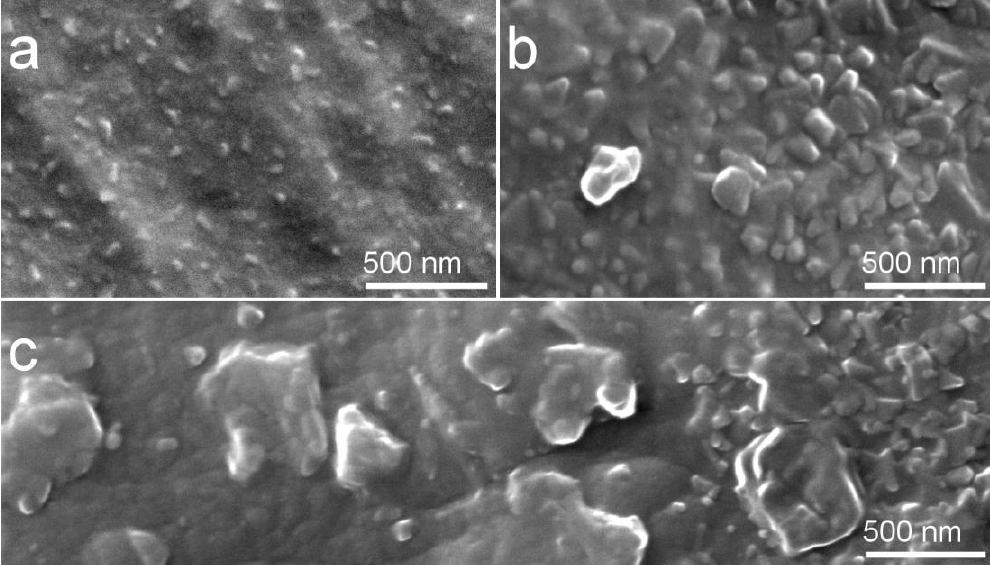
Figure 4. Scanning electron microscope (SEM) image of the Cu-HA coating on Mg0.8Ca alloy after HT at 450 °C showing fine crystallites ( a ) Cu-HA coating on Ti after HT at 700 °C showing the same type of crystallites of increased size( b ) and Cu-HA coating on Ti after HT at 700 °C showing agglomerates of crystallites ( c ).